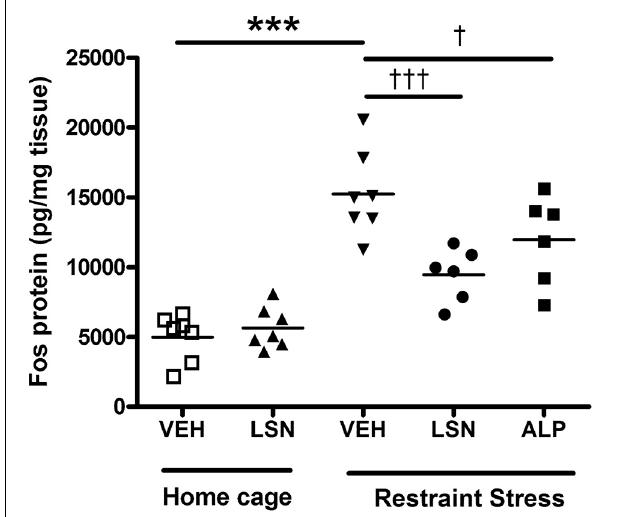
FIGURE 2 | c-Fos protein expression in rat prefrontal cortex with and without restraint stress. In the absence of stress, LSN2424100 ( n = 7) had no effect on c-fos levels compared to vehicle treated subjects ( p > 0 . 05; n = 7). Restraint stress significantly increased c-fos levels